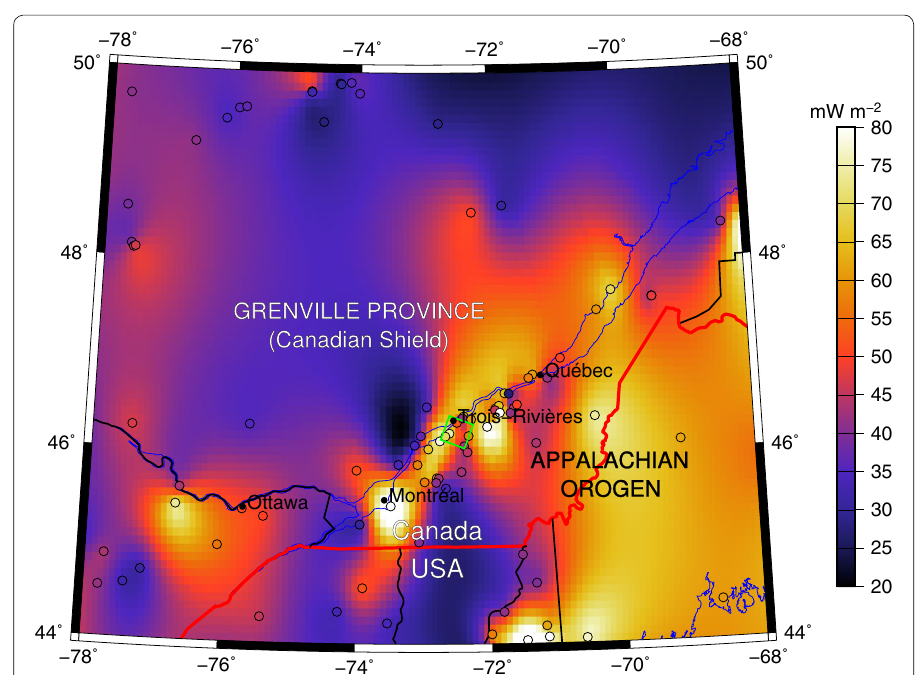
Fig. 1 Surface heat flow in southwestern Québec. Open circles show the data points of heat flow values based on Perry et al. (2010) and references therein; Bédard et al. (2016); SMU Geothermal Laboratory (2018); Jean-Claude Mareschal, pers. comm. Green box is the study